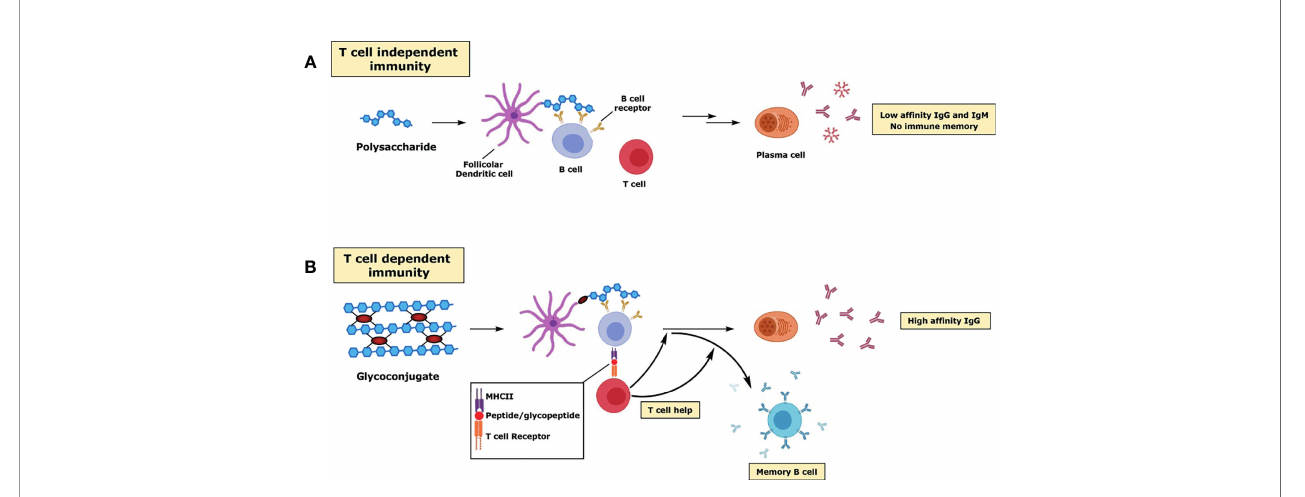
FIGURE 1 | Schematic representation of the immune response to polysaccharides (A) and glycoconjugates (B)